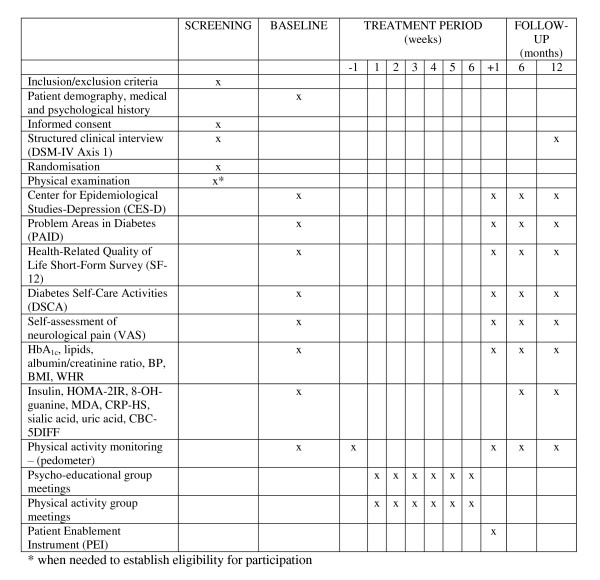
Study flowchart.